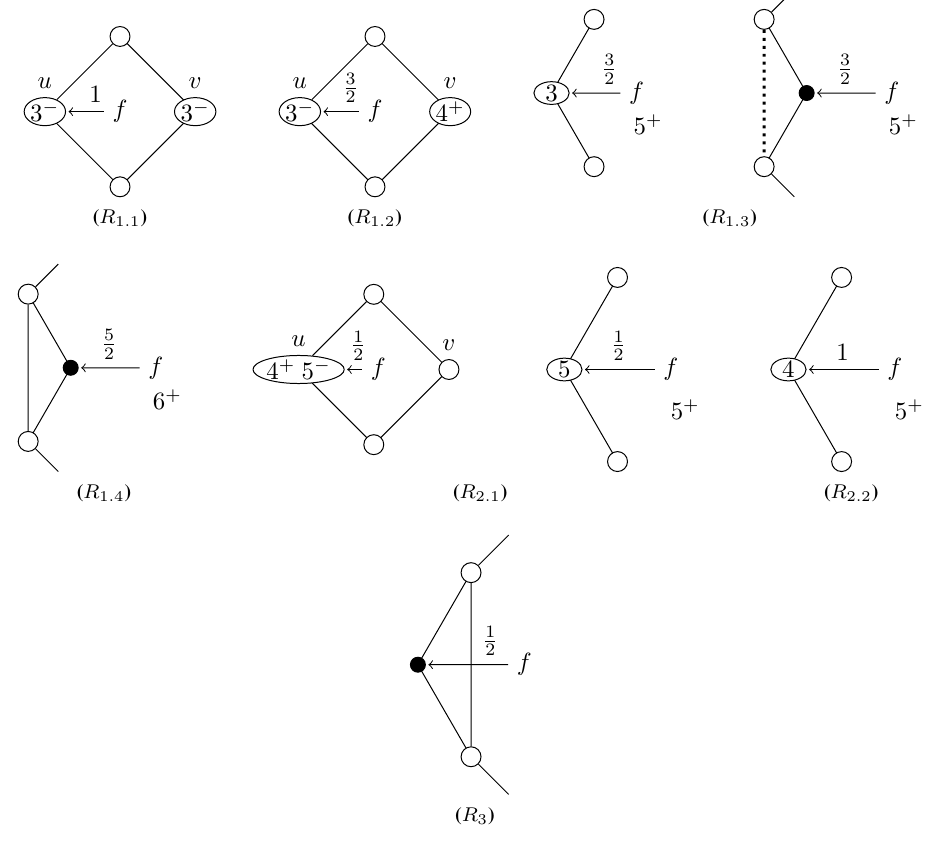
Fig. 3: Discharging rules R 1 , R 2 and R 3